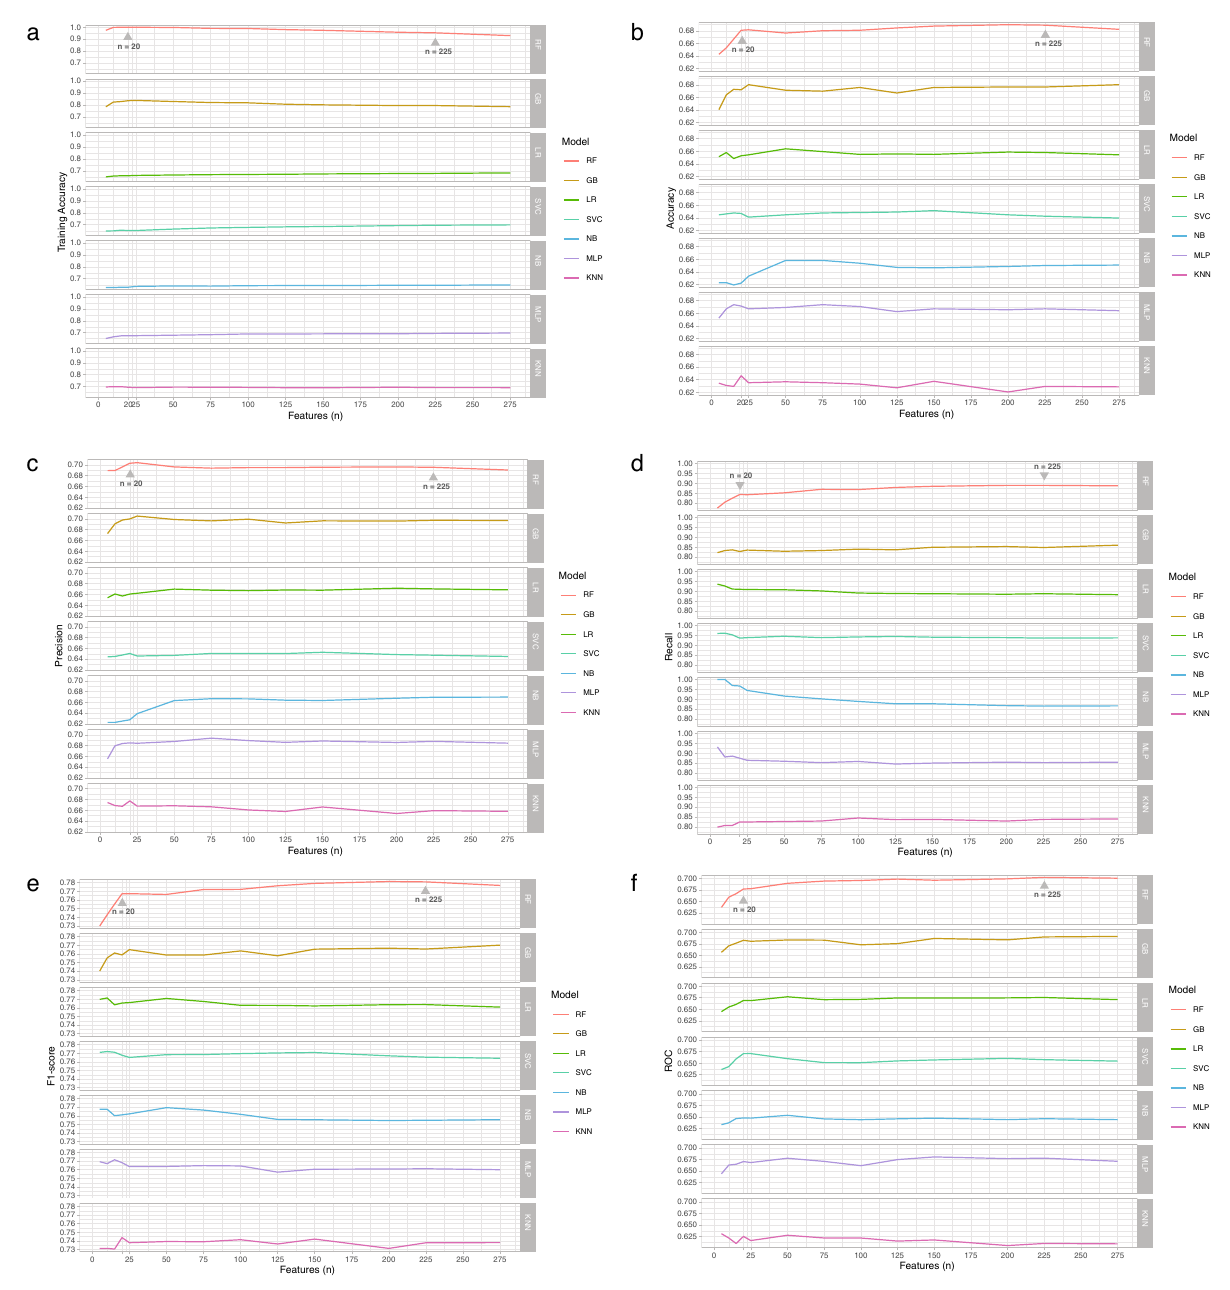
Figure 4. Machine learning performance patterns of different amount of features (5–275 features). ( a ) Accuracy of training dataset. ( b – f ) Accuracy, Precision, Recall, F1-score, and AUROC of the testing